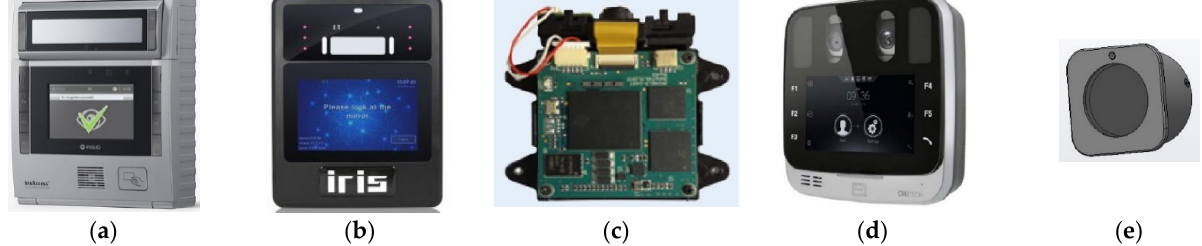
Figure 3. Examples of existing access control devices, based on iris recognition, intended for smart-city applications: ( a ) IRISID-iCAM7; ( b ) GRANDING-IR7pro; ( c ) IRITECH-MO2121; ( d ) THOMAS-TA-EF-45; ( e ) proposed concept design. Table 1. Typical technical characteristics of products from smart-city access control applications, based on iris recognition. Company/Product